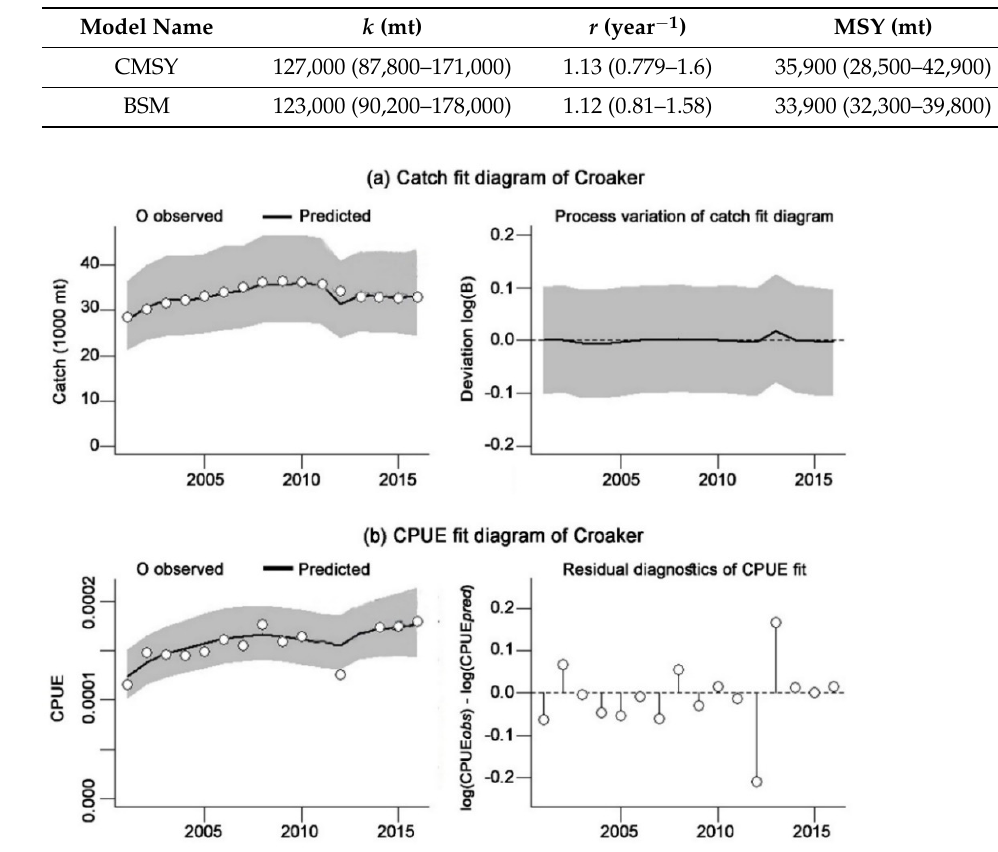
Figure 3. Schematic plots ( a ) represent the observed and predicted catch fit diagram, and ( b ) represent the observed and predicted CPUE fit diagram for the croaker fishery in the BoB derived from the CMSY method with 95% confidence limits (gray shaded).